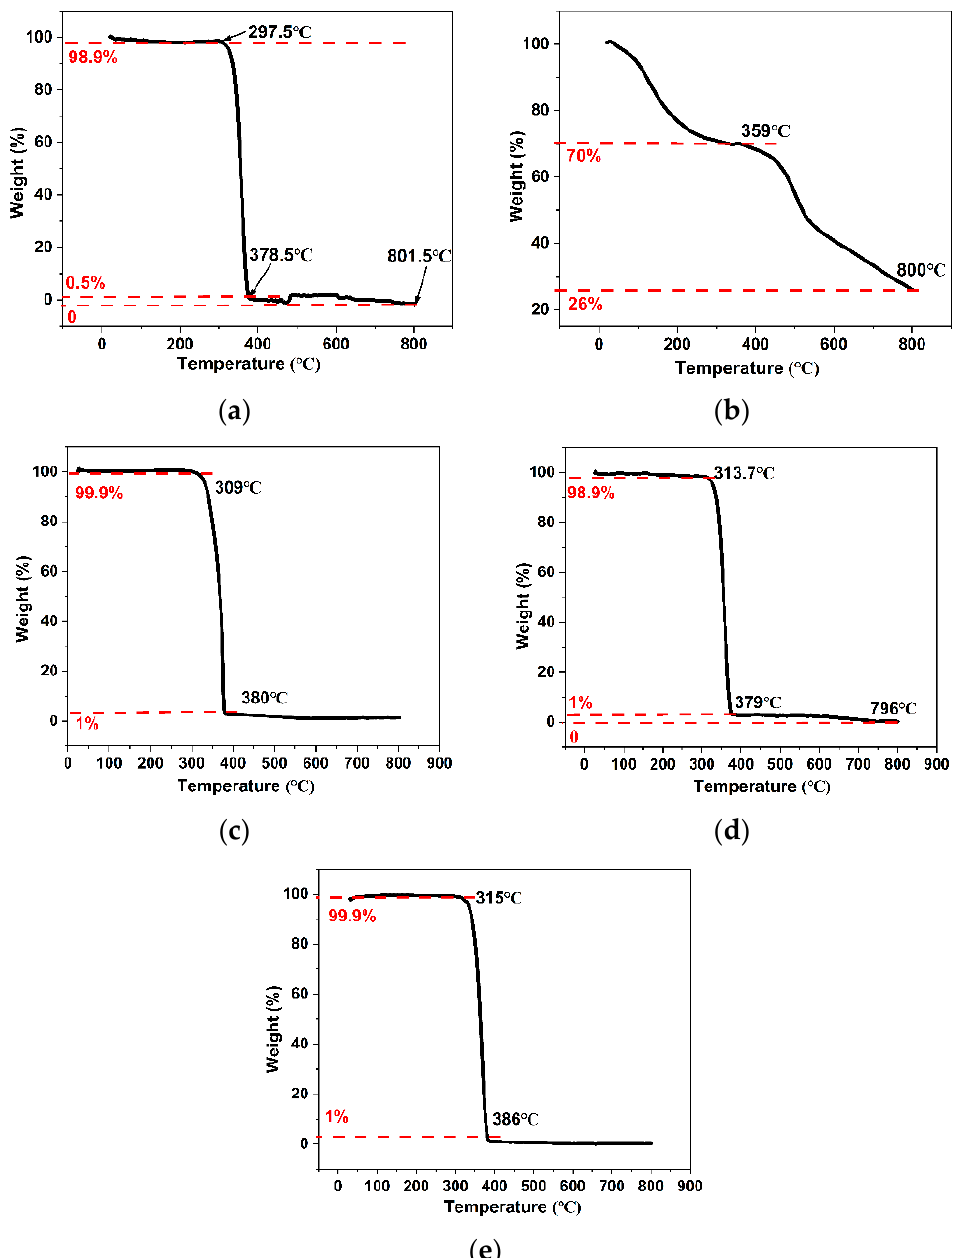
Figure 7. Thermogravimetric curves of ( a ) PLA, ( b ) COFs, ( c ) COF-PLA (COF/PLA: 1/300), ( d ) COF- PLA (COF/PLA: 1/500), and ( e ) COF-PLA (COF/PLA: